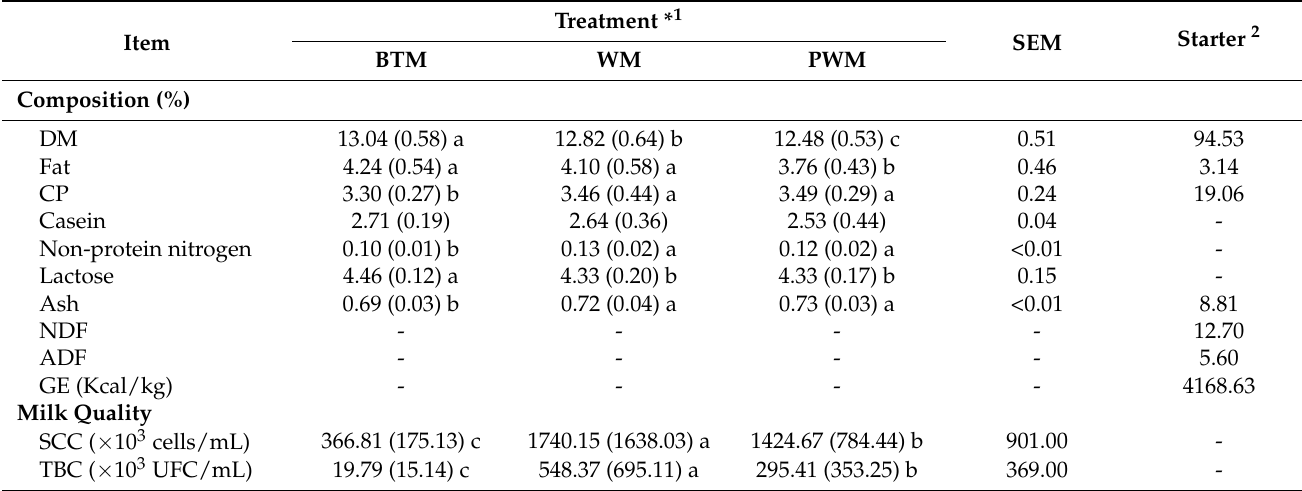
Table 1. Composition, somatic cell count (SCC), and total bacterial count (TBC) of bulk tank milk (BTM), waste milk (WM), and pasteurized waste milk (PWM) samples and composition of concentrate used during the period from 4 to 60